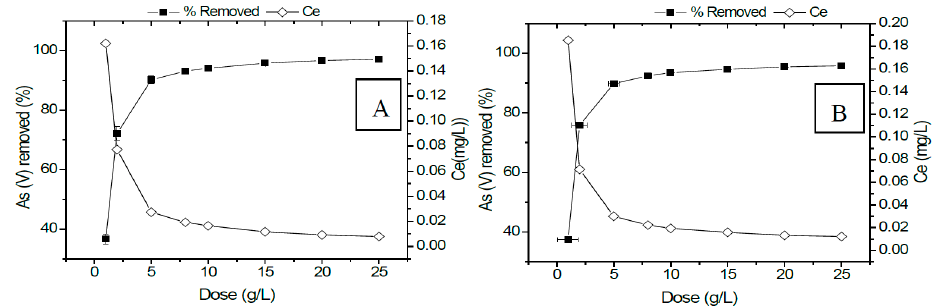
Figure 8. Effect of adsorbent dose on removal of As(V) by ( A ) Ch–Rs ( B ) Ch–Pu blends (initial As(V) concentration 0.25 mg/L, pH 7, shaking 2 h at 200 rpm at 24 ± 1 °C).